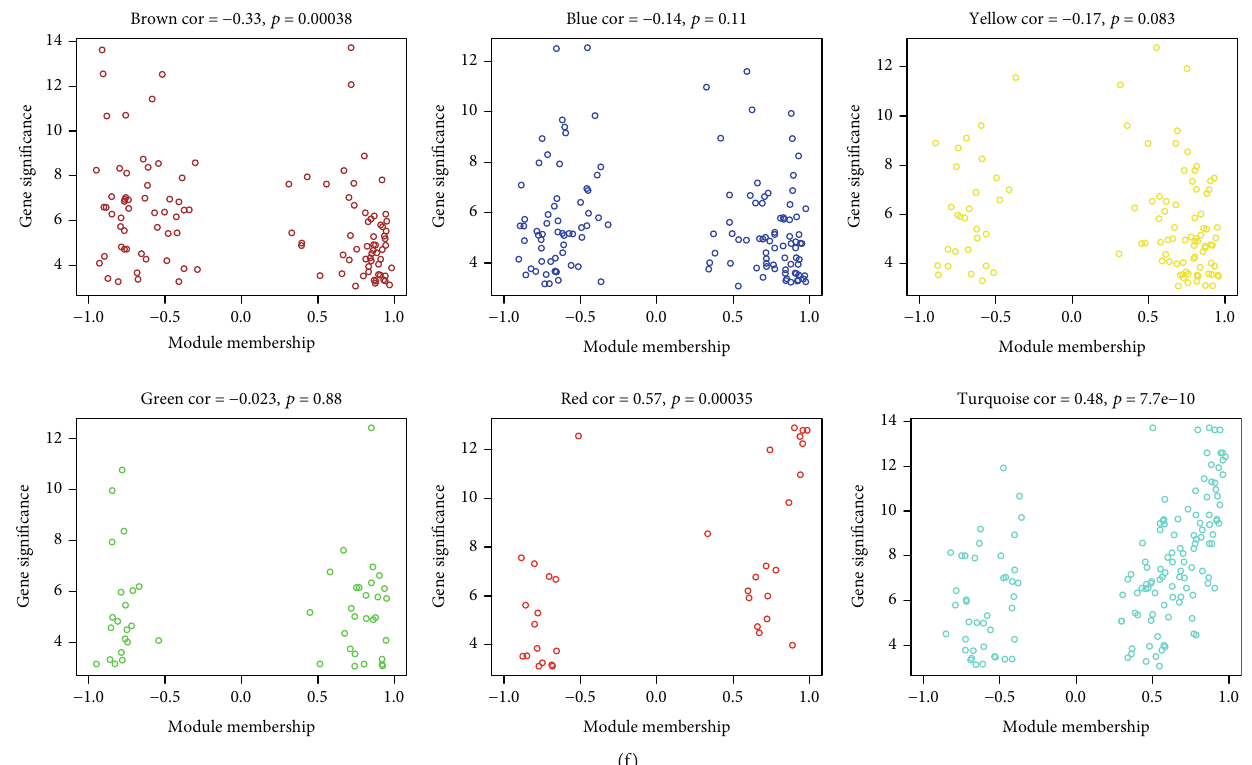
Figure 3: Construction of weighted coexpression network and module analysis. (a) Soft-threshold selection. A soft-threshold power of 7 with an R 2 of 0.87 was selected. (b) Cluster dendrogram. Each color indicates one speci fi c coexpression module, and each vertical line indicated an individual gene. Six modules were identi fi ed in WGCNA, including blue, brown, green, red, turquoise, and yellow module. (c) Network heat map plot of all genes suggesting the interaction of coexpression genes via TOM dissimilarity. The axe colors indicate the respective modules. The color intensity represents the degree of overlap, where a darker yellow suggests a higher degree of connectivity. (d) Barplot of mean gene signi fi cance associated with HCC. A higher value shows a more signi fi cant relationship. (e) Relation between di ff erent module eigengenes. (f) Scatterplots of genes in the six modules. Module membership is set as the x -axis, whereas the y -axis is gene signi fi